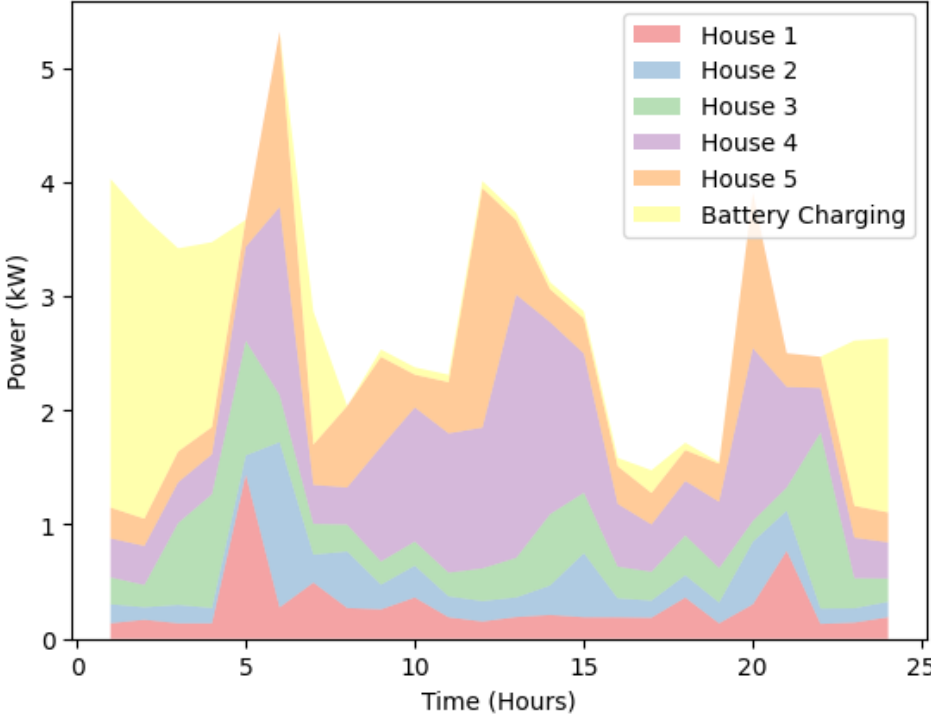
Figure 8. Total demand of the community on the first day after applying the model.